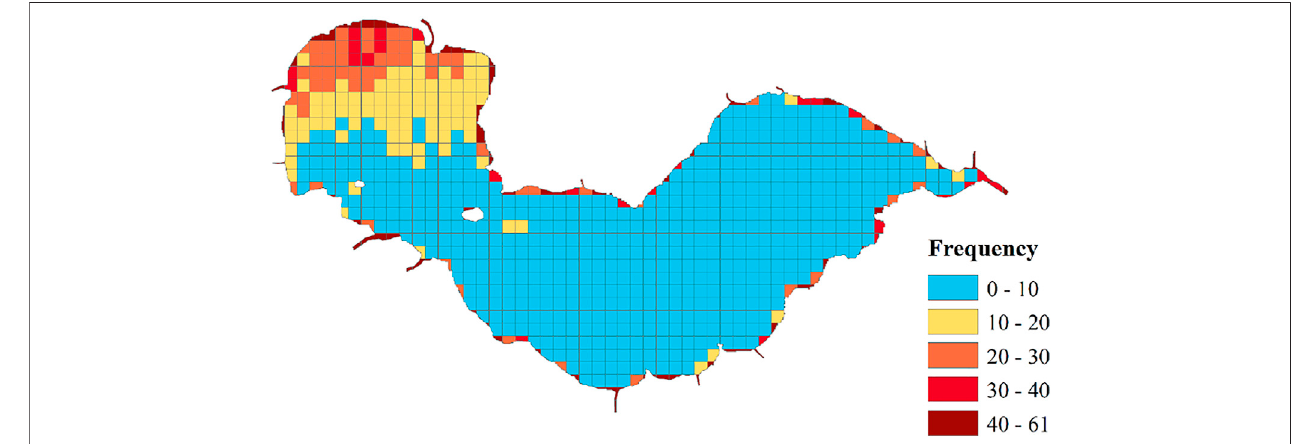
FIGURE 11 | Algal bloom frequency map for each grid cell (number of grid cells: 850).